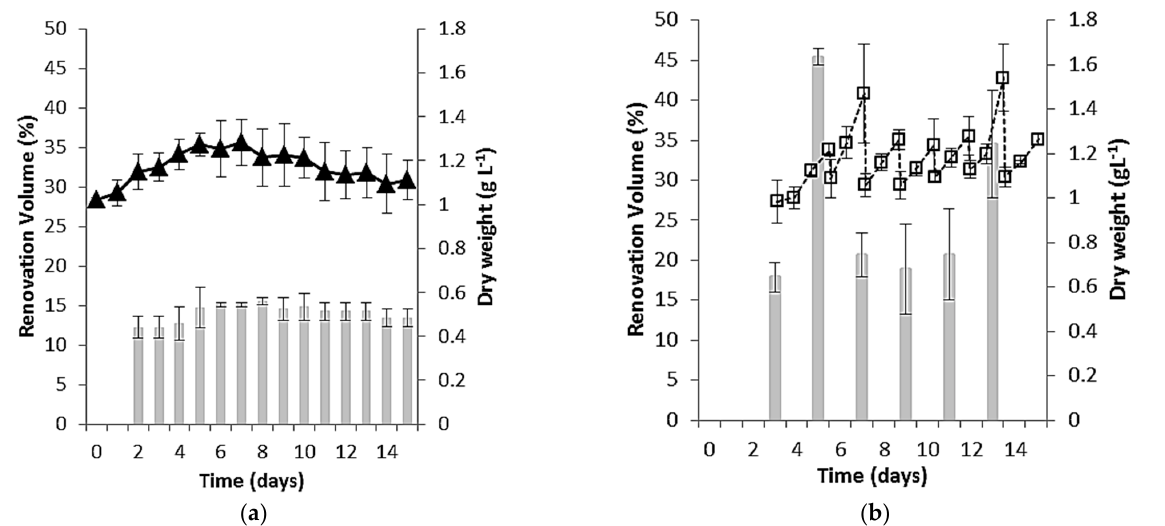
Figure 4. Nannochloropsis oceanica growth in 2.6 m 3 PBRs in continuous ( a ) and semi-continuous ( b ) operation regimes. The bars represent the percentage of volume renewed with fresh medium. All the values represent an average of three biologically independent replicates, with the respective standard deviation.